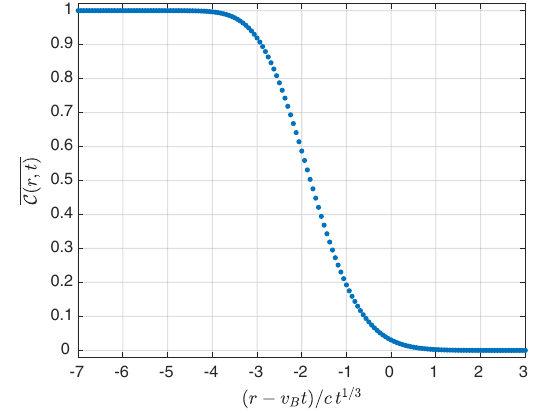
FIG. 9. The OTOC in ð 2 þ 1 Þ D: Plot of the front of the averaged OTOC C ð r; t Þ in two spatial dimensions and in the absence of lattice anisotropy, as determined from the exact expression in terms of the Tracy-Widom distribution in the main